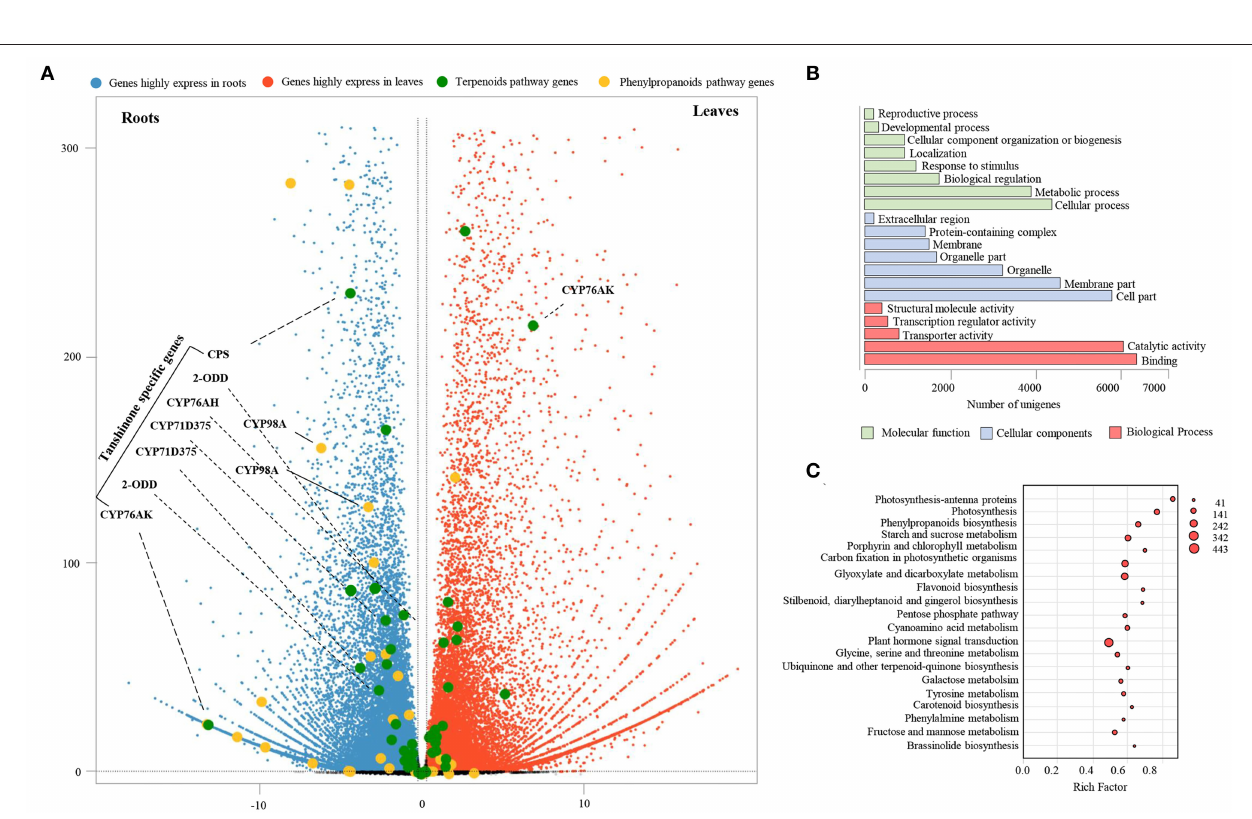
FIGURE 4 | Transcription profiles of S. apiana roots and leaves. (A) Volcano plots represent the differentially expressed genes (DEGs) with higher transcriptional level in roots (blue plots) and leaves (red plots), respectively. The genes involved in terpenoids (green plots) and phenolic acids (yellow plots) biosynthesis are marked. (B) Statistical analysis of the most enriched GO terms from three major categories. (C) The top twenty KEGG pathways with the most significant variations of DEGs between the roots and leaves. The number of DEGs is represented by the size of circle.